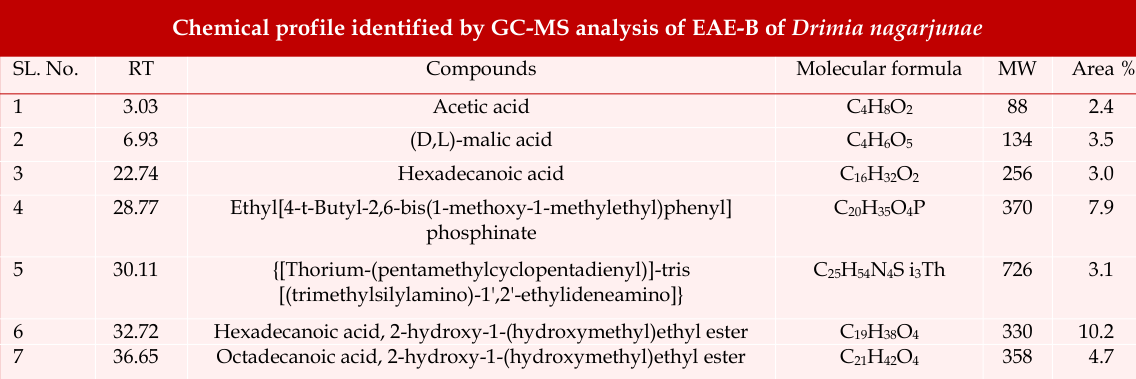
Chemical profile identified by GC-MS analysis of EAE-B of Drimia nagarjunae SL.